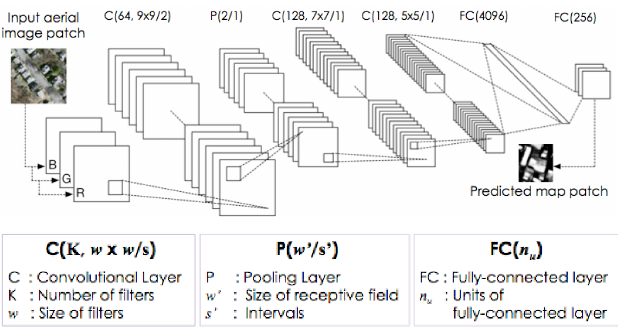
Figure 3. The base architecture of CNN 2.3 Mapping Onto 5D World Map